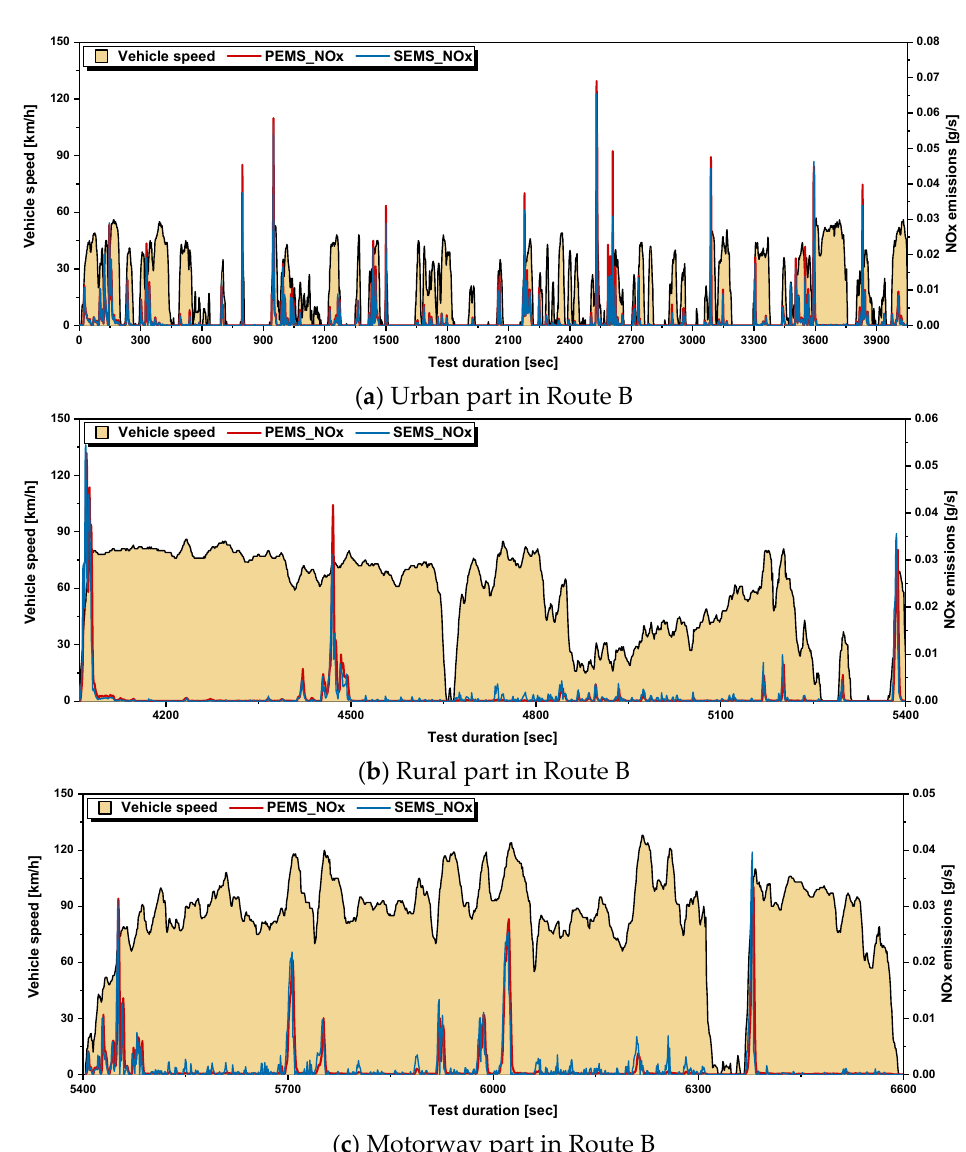
Figure 19. Real-time profiles of NOx emissions measured by the PEMS and SEMS equipment under RDE Route B.